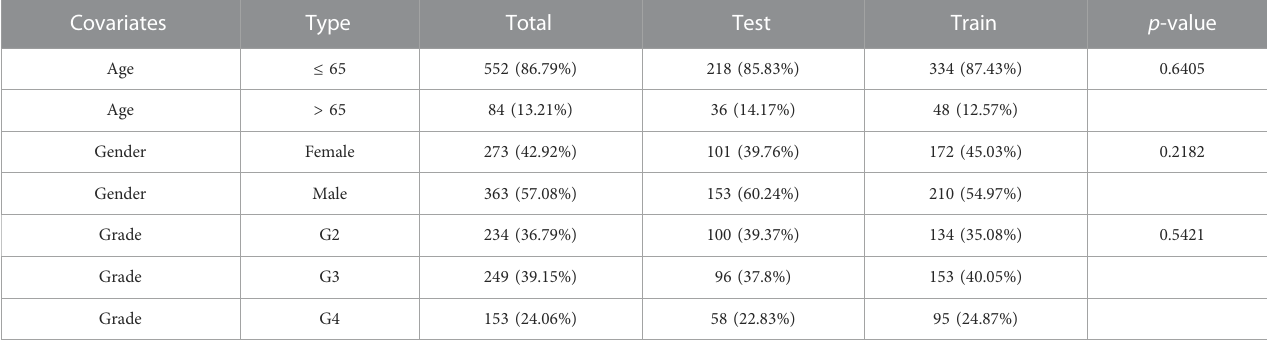
TABLE 1 Baseline characteristics of the glioma patient in training and testing